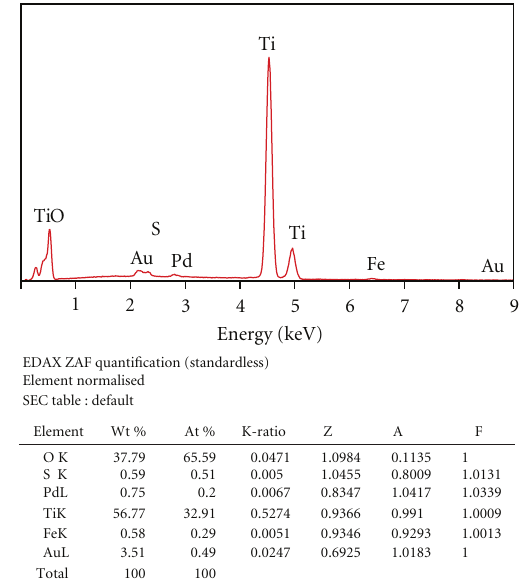
Figure 5: EDS analysis of the sample TIT 144 ground with ammonium carbamate addition.